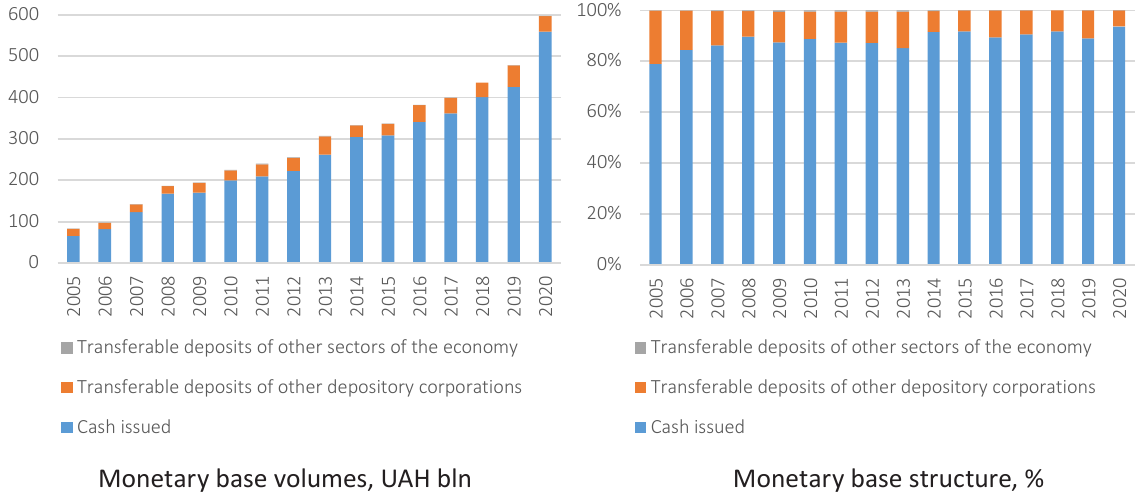
Figure 1. Volumes and structure of Ukrainian monetary base in